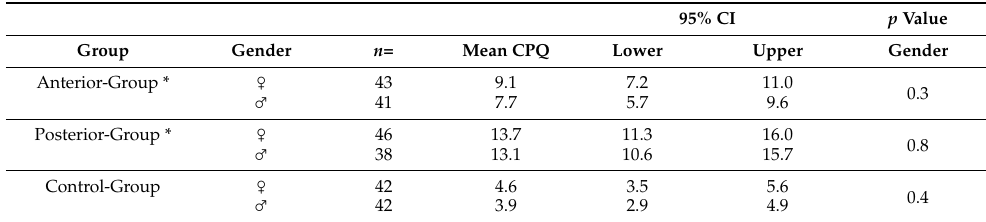
Table A6. Test for significant differences between mean of Total-CPQ-Scores in Anterior-, Posterior- and Control-Group and their